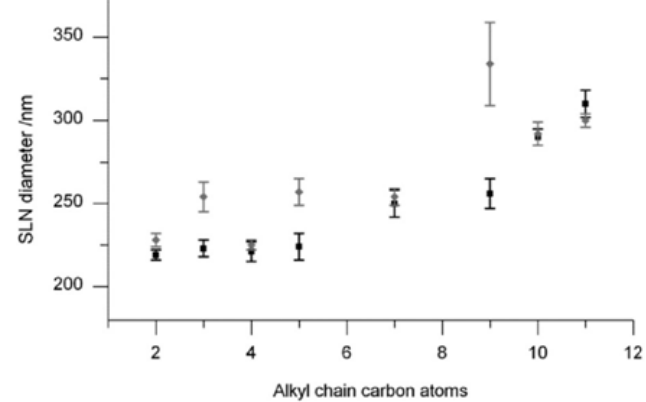
Figure 46. SLN diameters for all CNBC5 24 (mean of the size distribution from DLS showing standard deviation). SLNs with a constant 0.1 mM concentration ( black ) and with a constant mass 100 mg L − 1 ( grey ) show increasing diameter for longer alkyl chains